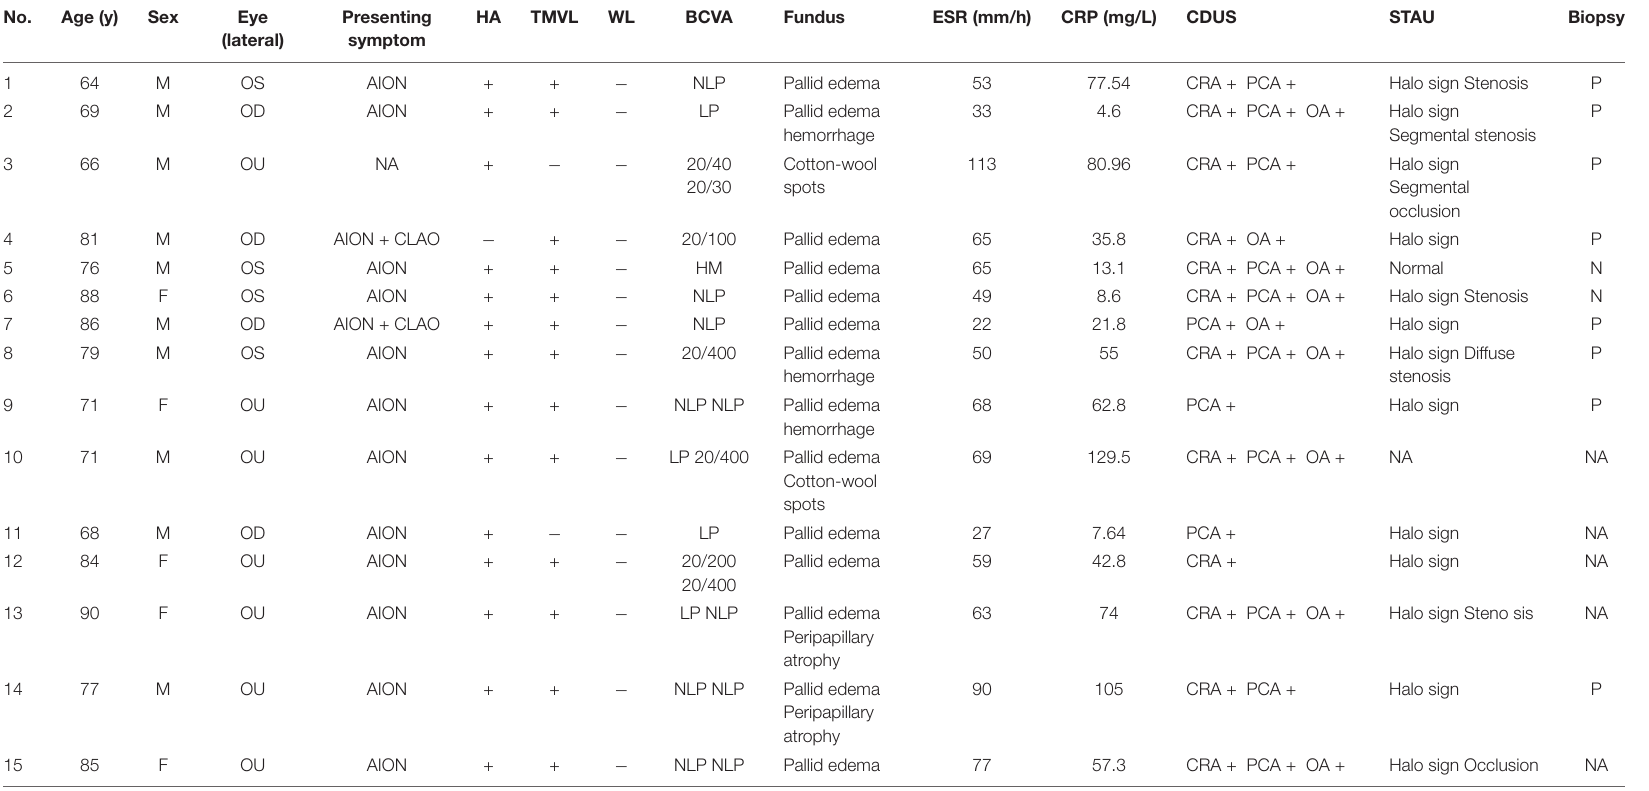
TABLE 1 | Demographic and clinical characteristics of giant cell arteritis Chinese patients.